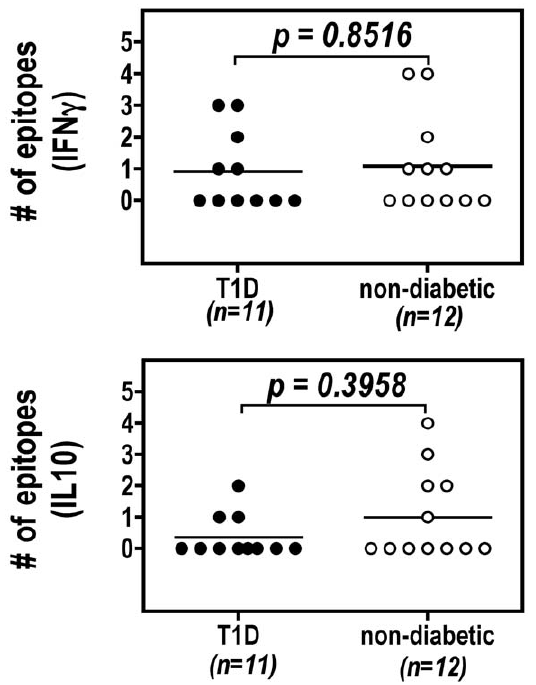
Figure 5. The counts of epitope specific IFNgamma (A) or IL10 (B) response for each individuals. Each circle represents a diabetic (filled circle) or a non-diabetic subject (open circle). A Mann-Whitney test was used for statistical